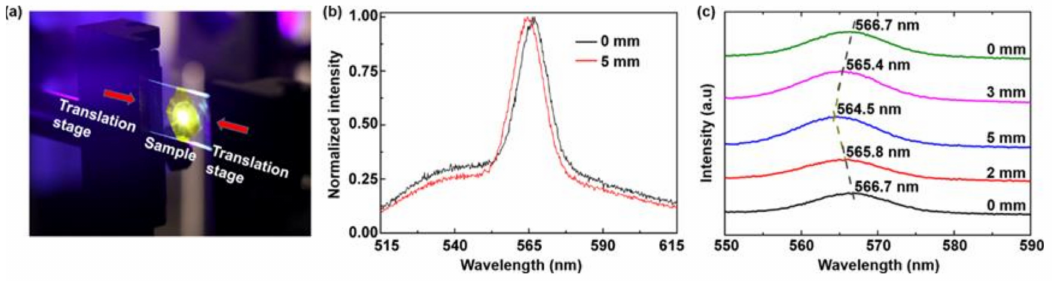
Figure 5. ( a ) Experimental set-up for compression (0 mm–2 mm–5 mm) and restoring (5 mm–3 mm–0 mm) processes. ( b ) Tuning of emission wavelength by bending the random laser. ( c ) Spectral evolution of the random laser under bending and recovering